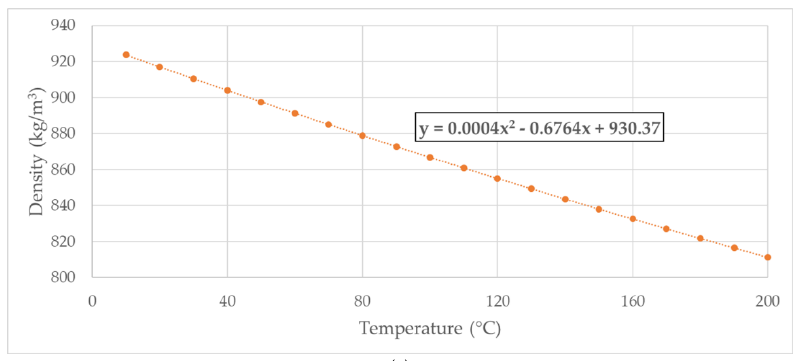
Figure 9. Eco-friendly fluids properties: ( a ) BIOHYDRAN TMP 46: density vs. temperature; ( b ) BIOHYDRAN TMP 46: viscosity vs. temperature; ( c ) olive oil: density vs. temperature; ( d ) olive oil: viscosity vs. temperature. Table 4. Molecular weight, specific heat, speed of sound, and thermal conductivity of the three